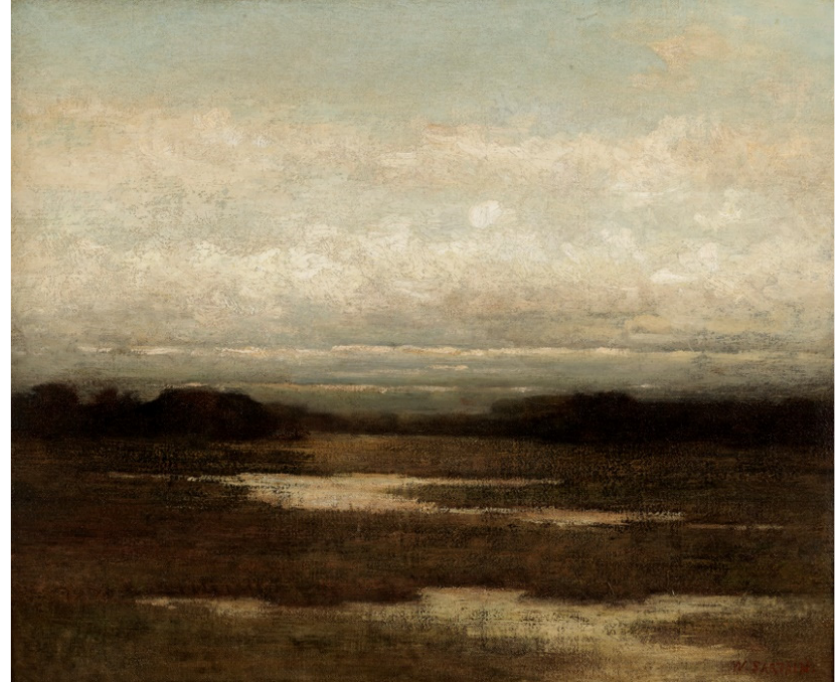
Figure 18. William Sartain, Solitude , by 1892, oil on canvas, 51.1 × 61.1 cm, Pennsylvania Academy of the Fine Arts, Philadelphia, PA. Gift of Mrs. James Mapes Dodge in accordance with the wishes of the artist. 1931.13.1.